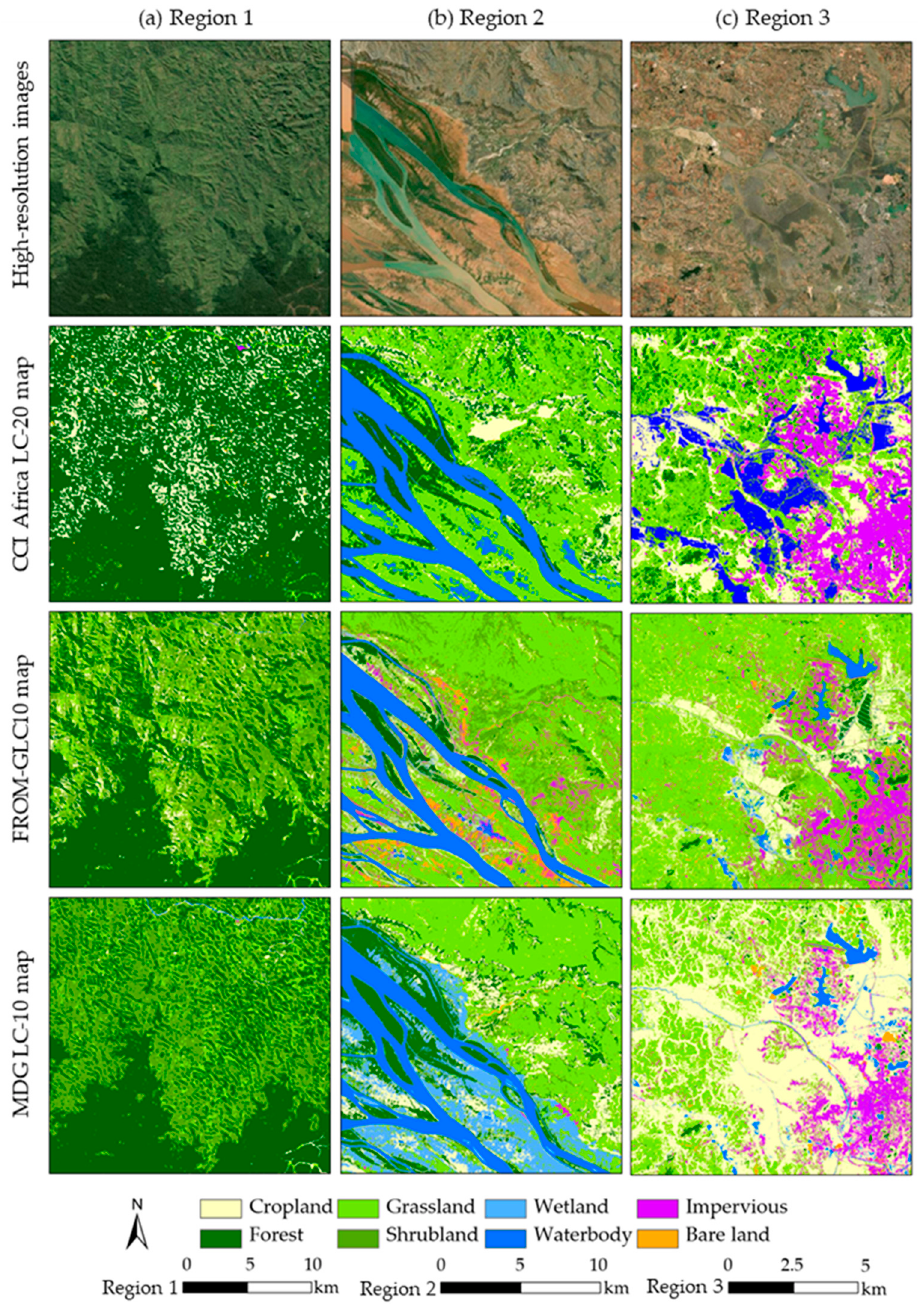
Figure 4. Visual comparison of three zoomed areas ( a – c ) among the MDG LC-10 map, two high resolution land cover maps (i.e., the CCI Africa LC-20 map and the FROM-GLC10 map) and very high resolution imageries from Google Earth.